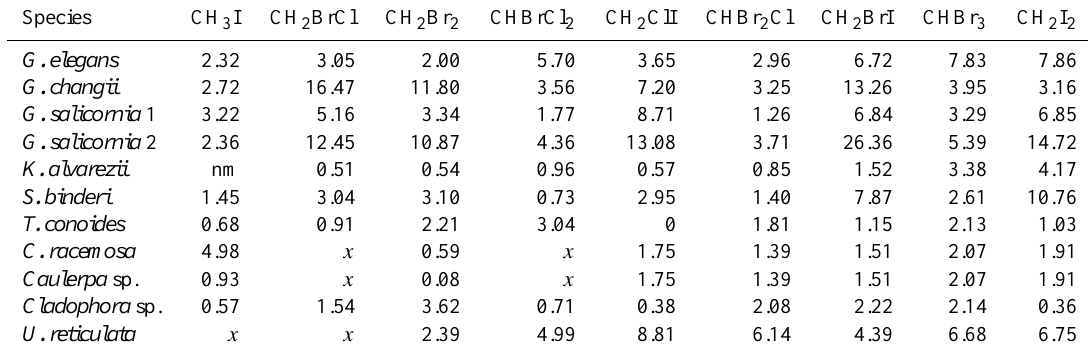
Table 2. Ratio t 4: t 24 halocarbon production rates. Production (pmolgFW − 1 h − 1 ) was higher at t 4 for all but one occurrence. nm=not measured, x =at one or both time points compound not detected. Production by P. australis , S. baccularia , S. siliquosum and Bryopsis sp. was not measured at t